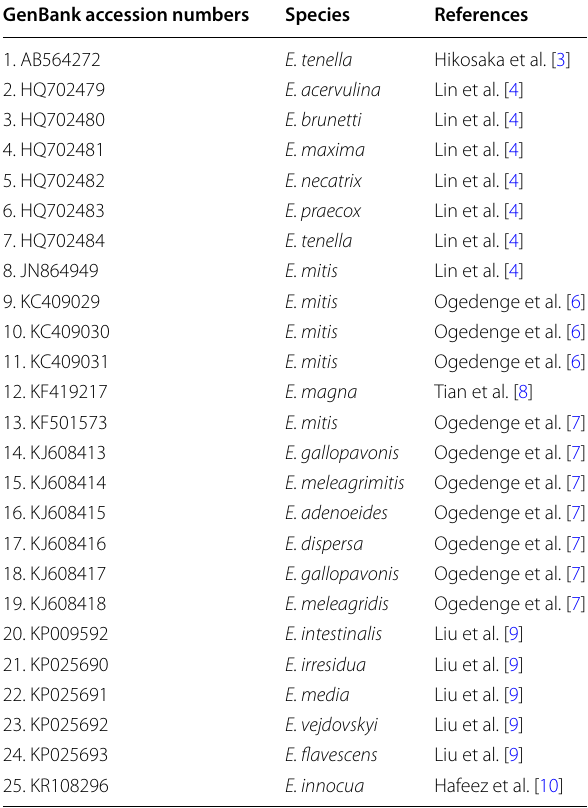
Table 1 List of mtDNA genomes of Eimeria species